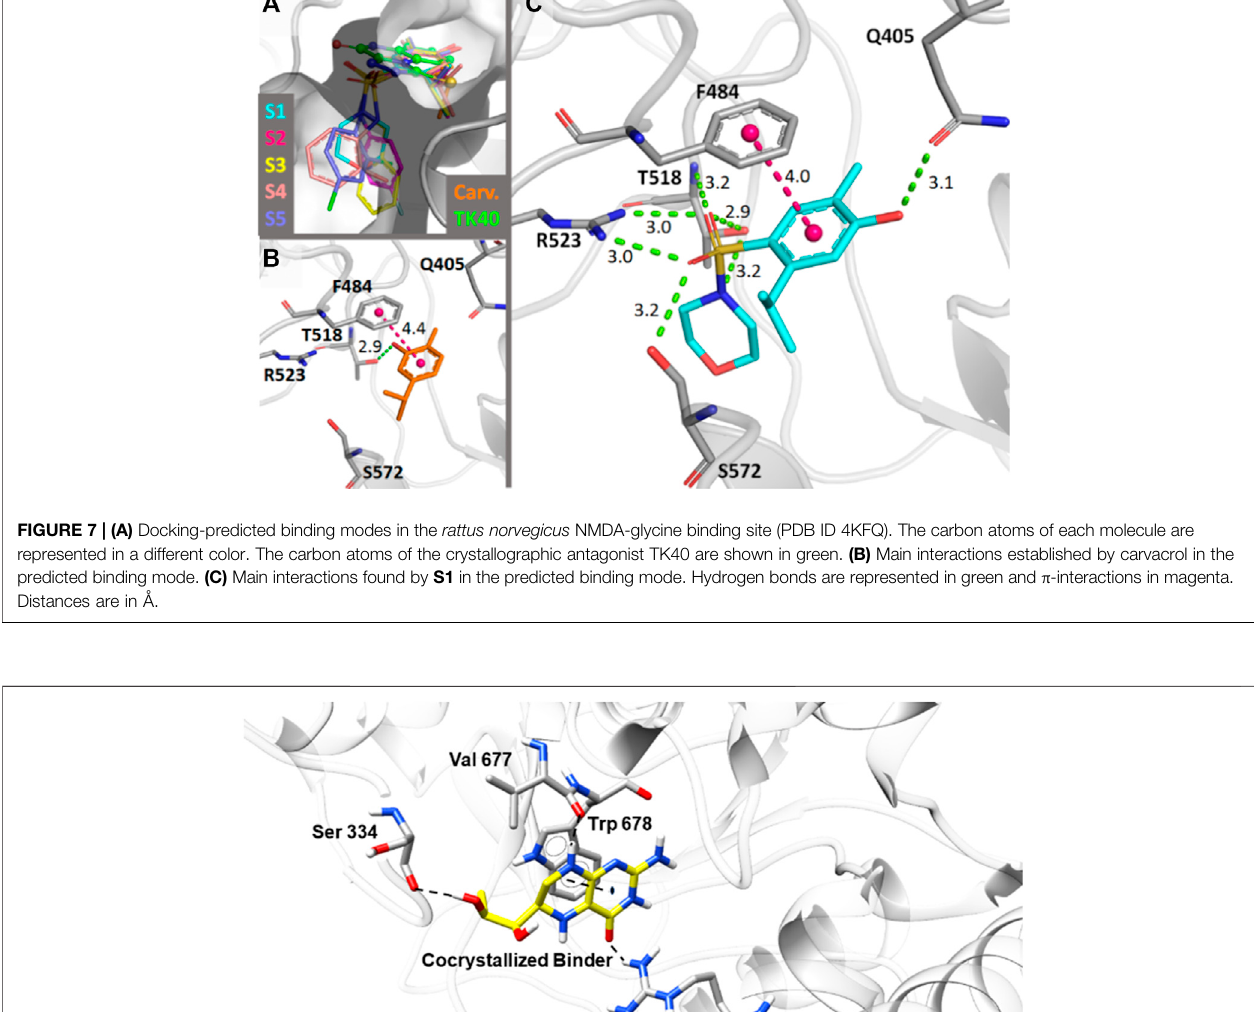
Frontiers in Pharmacology |